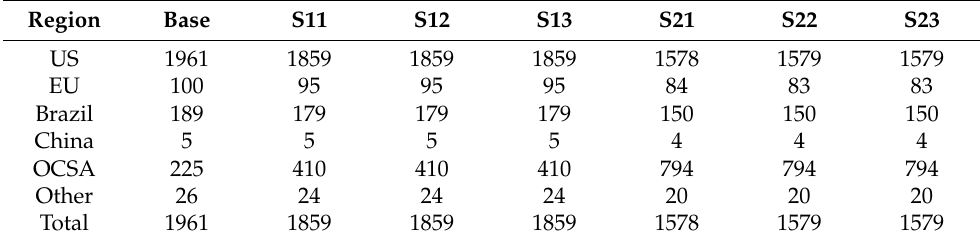
Table 3. EU imports of soybeans by exporting region for all examined scenarios (in million USD). Region